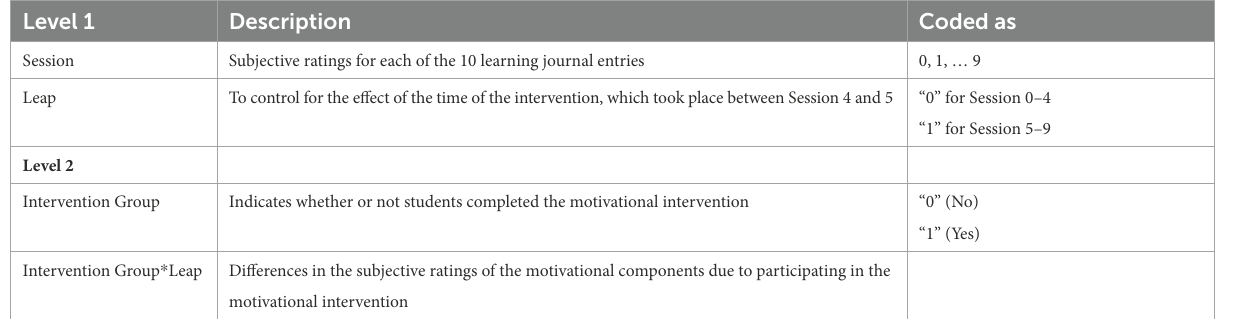
TABLE 4 Variables added as predictors for each of the two levels of the multilevel